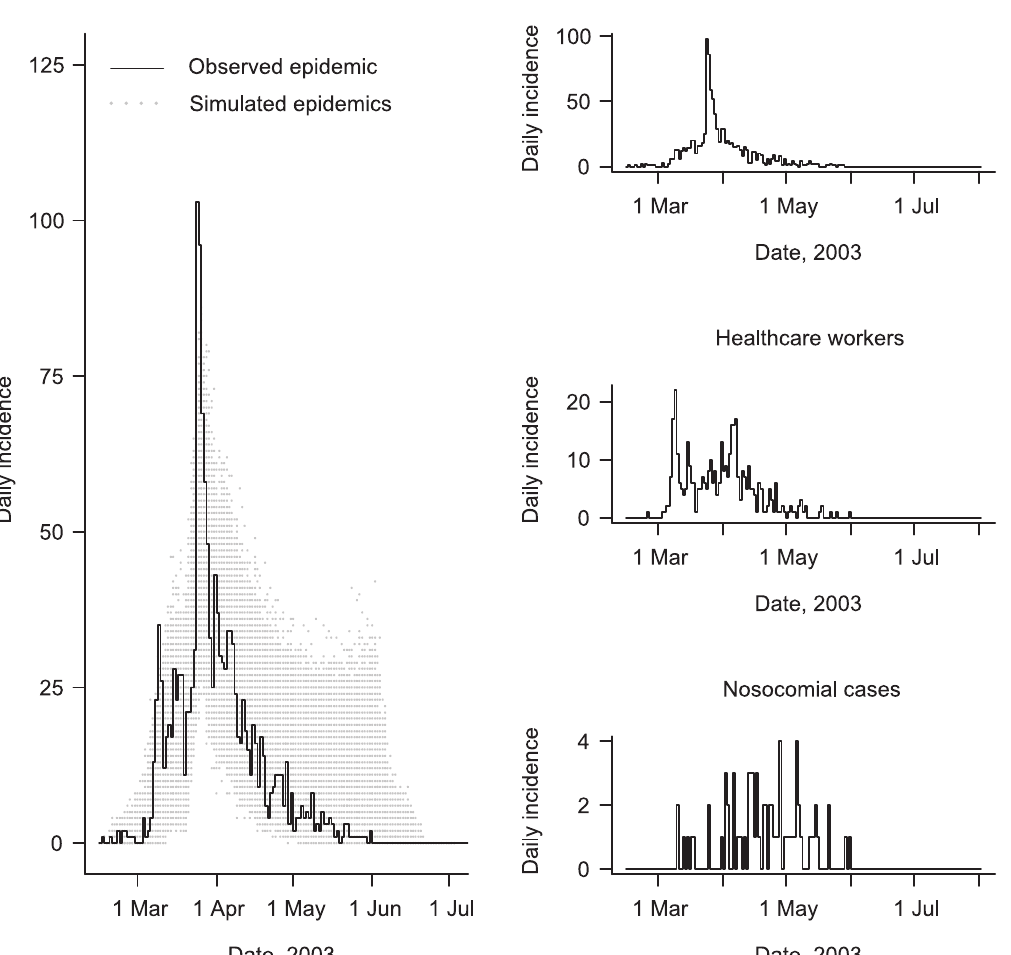
Figure 2. Daily Incidence of SARS Symptom Onset (Observed and 5 6 10 4 Simulated Epidemics), Hong Kong, 2003. Cases were defined as: nosocomial when patients had been hospitalized for $ 5 days before symptom onset ( n ~ 72) ; healthcare workers when they were indeed healthcare workers and not nosocomial ( n ~ 394) ; and general population, otherwise ( n ~ 1001) . The grey cloud surrounding the observed epidemic curve corresponds to simulated epidemic curves.